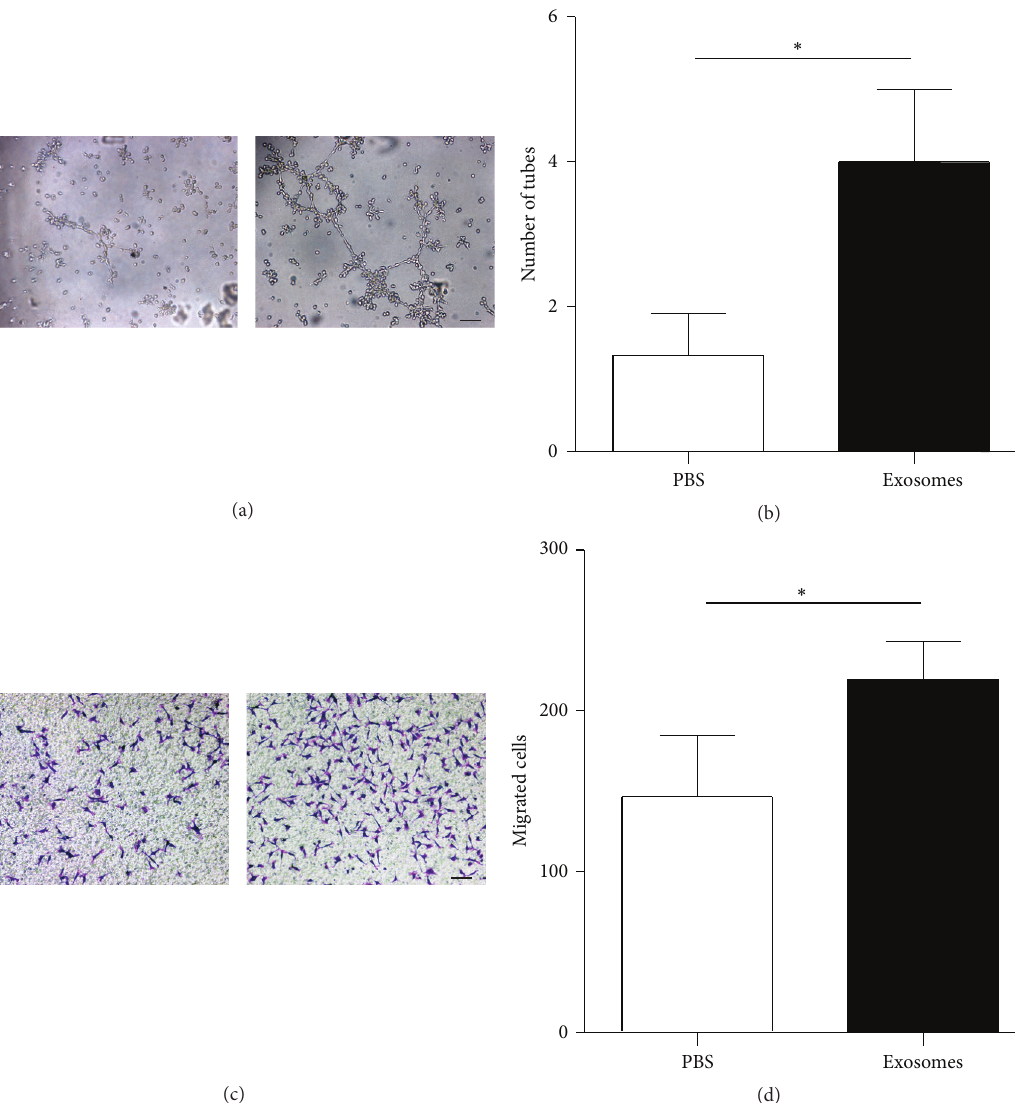
Figure 7: hucMSC-exosomes accelerated tube-like structure formation and migration of EA.hy926 cells. Representative photomicrographs of tube-like structure (a) and quantification of tube number (b). Scale bar = 100 𝜇 m. ∗ 𝑃 < 0.05 versus PBS control. Representative photomicrographs of EA.hy926 cells which migrated through the filter, stained with crystal violet (c). Quantification of cells migrated through the Transwell membrane (d). Scale bar = 100 𝜇 m. ∗ 𝑃 < 0.05 versus PBS